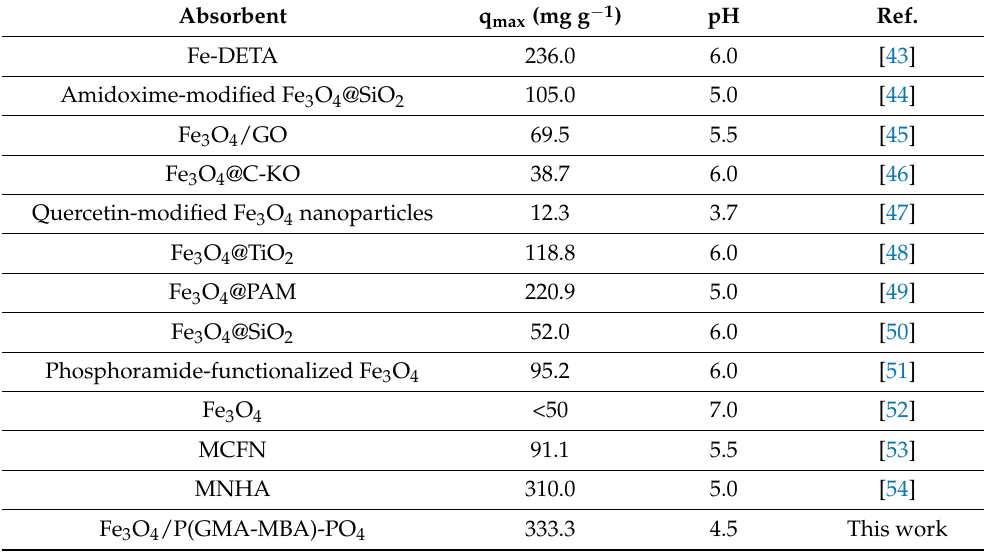
Table 1. Comparison of uranium adsorption performance between Fe 3 O 4 /P(GMA-MBA)-PO 4 and other